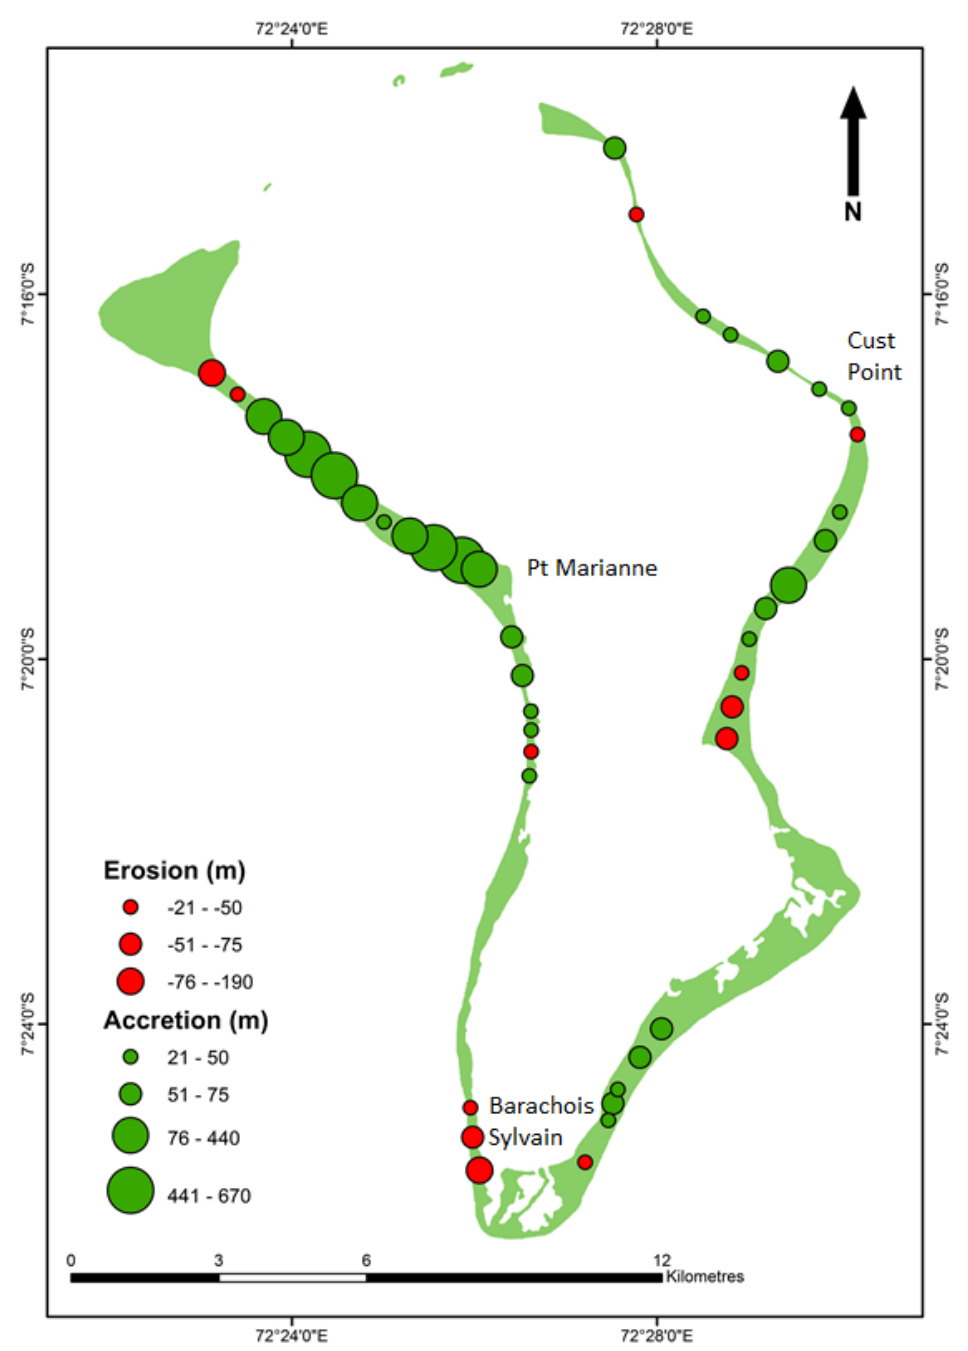
Figure 1. Revised estimates of change in rim width (metres) between Stoddart’s 1967 survey and the 2005 IKONOS satellite. Only points falling outside the margin of error are